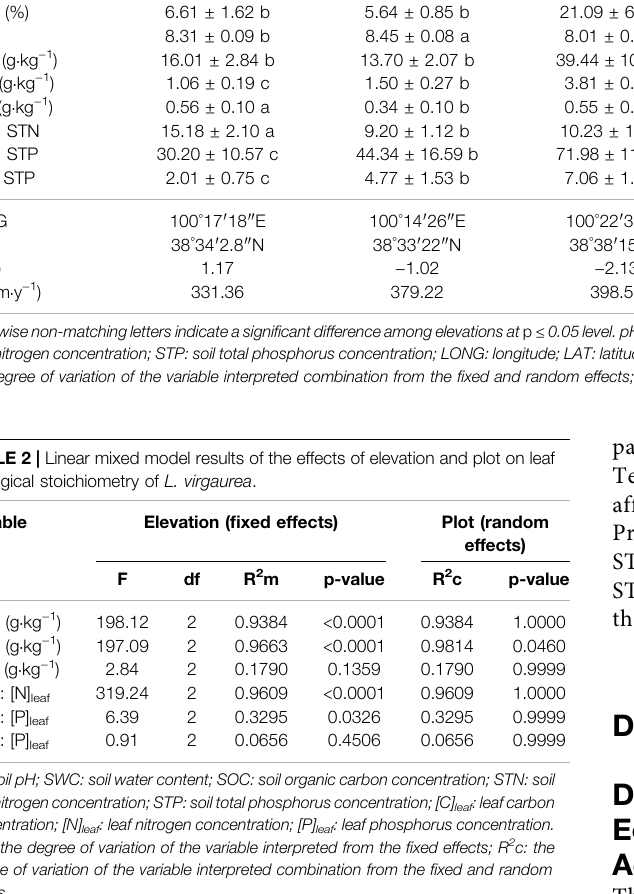
TABLE 1 | Soil properties, temperature and precipitation across the elevation gradient within the study area. Environmental factors